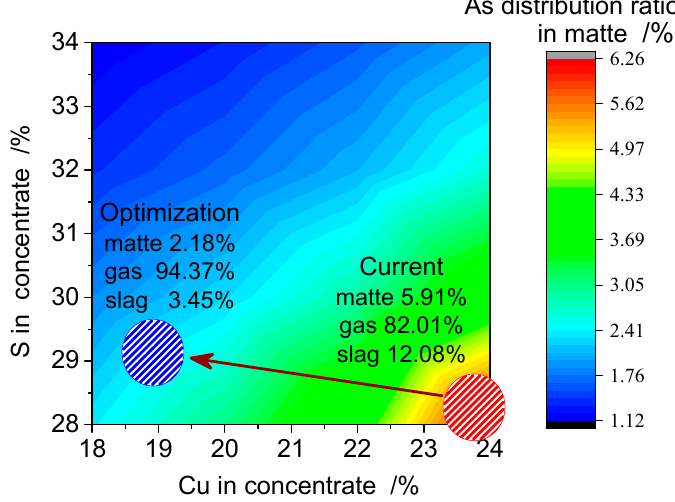
Figure 10. Optimization of ore proportions for arsenic removal in the Fangyuan 1 # smelter.